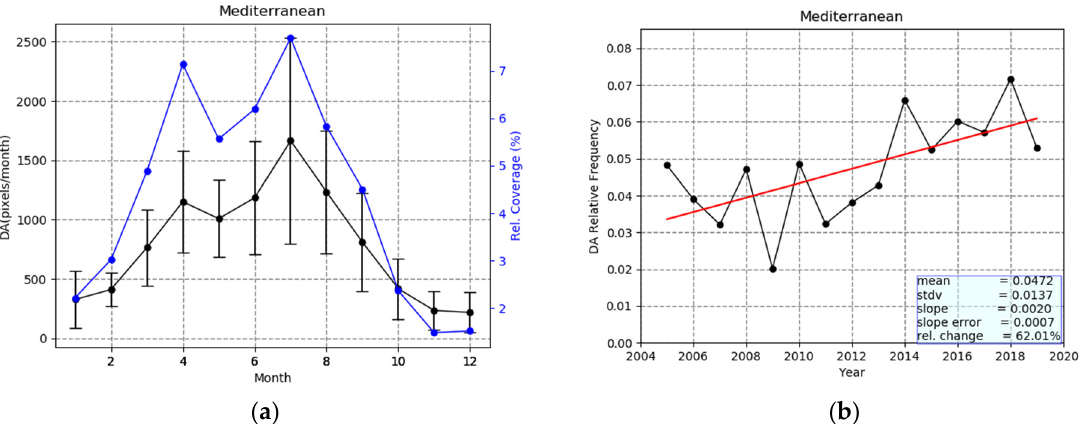
Figure 12. ( a ) Intra-annual variability of the 2005–2019 averages of the total absolute number of grid cells (1° × 1°) where dust aerosols (DA) were detected over Mediterranean by the satellite algorithm (left axis) and the percent coverage of the region by dusty grid cells (right axis). The error bars represent the year-by-year variability by means of computed 2005–2019 standard deviations. ( b ) Inter-annual variability and linear trend of the relative frequency of dust aerosols (DA) over the Mediterranean.